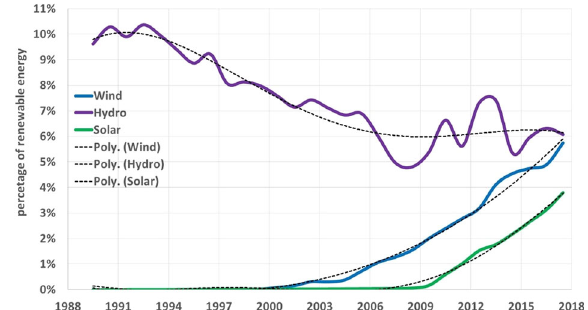
Fig. 2 Energy production by the source in the NEM grid during July 2019. a Totals. b Wind. c Solar photovoltaic facility. Images reproduced with permission from Aneroid Energy